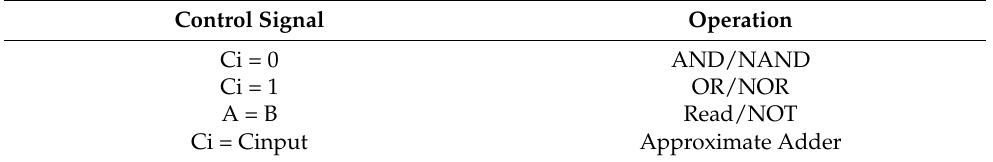
Table 1. Operation of the control signals. Control Signal Operation